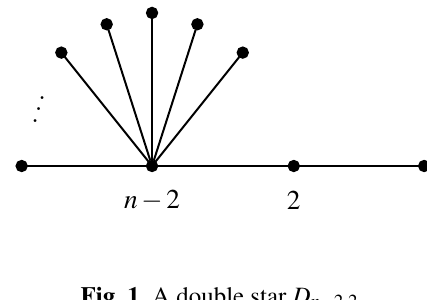
Fig. 1 A double star D n − 2 , 2